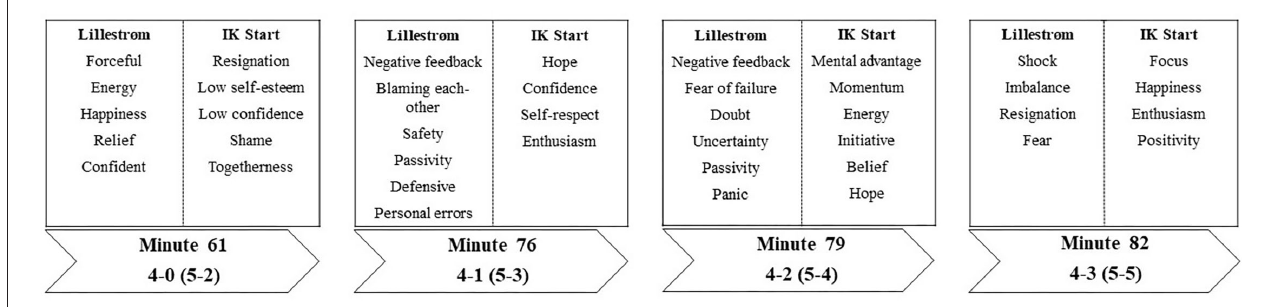
FIGURE 3 | Behavioral, cognitive, and emotional outcomes related to critical match-incidents from 4-0 (agg., 5-2) to 4-3 (agg., 5-5).